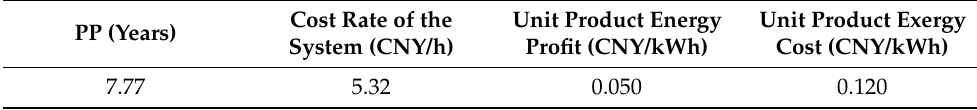
Table 5. The main system economic analysis factor.